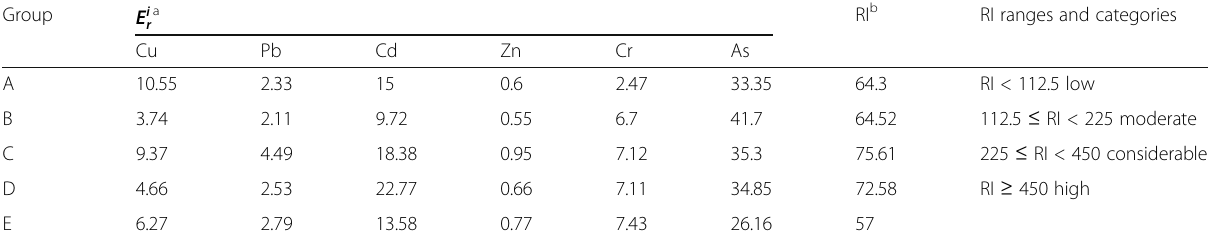
Table 6 Potential ecological risk index (RI) of metals in sediments of lakes along a rural to urban gradient in central China Group E i r a RI b RI ranges and